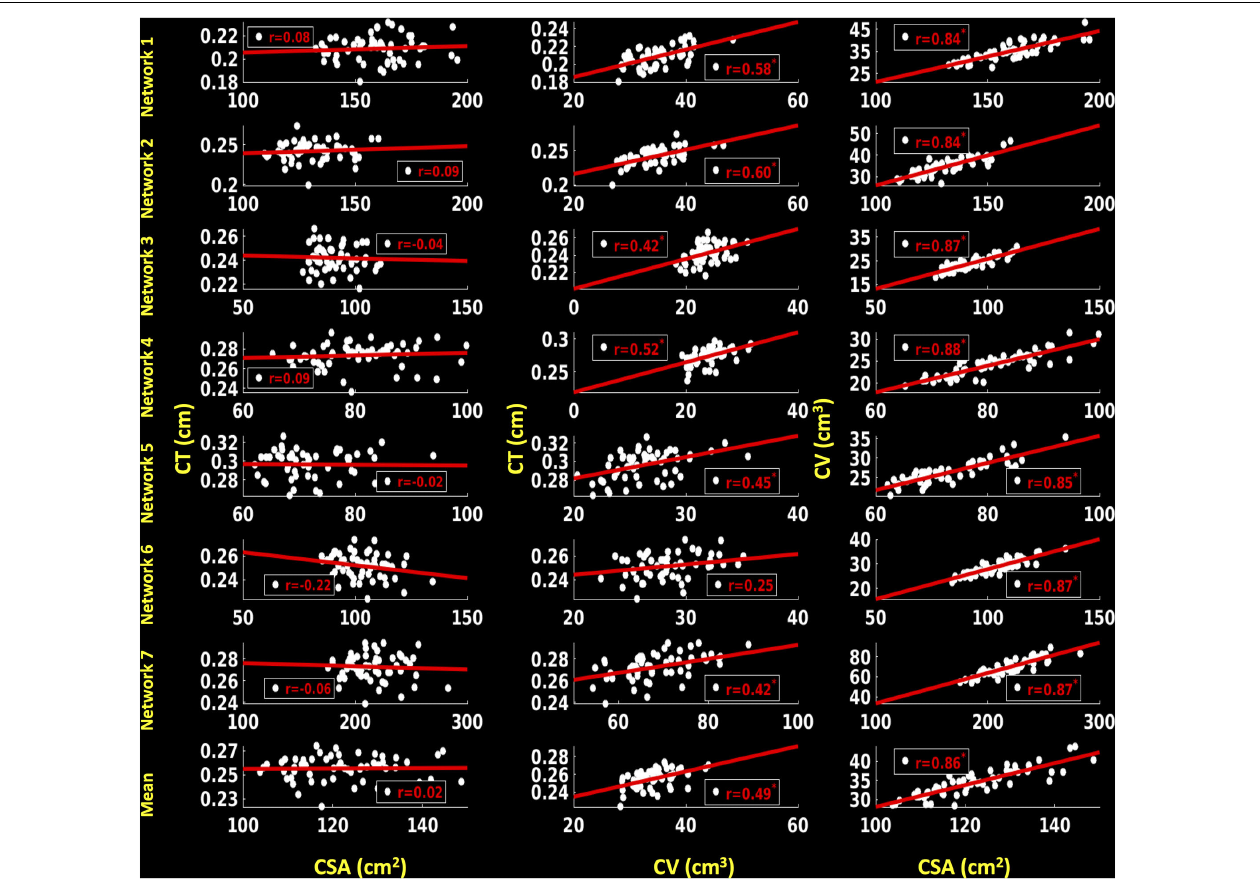
FIGURE 8 | Correlations between cortical surface area (CSA) and cortical thickness (CT), cortical volume (CV) and CT and between CSA and CV for left hemisphere. Linear plots showing non-significant association between CSA (cm 2 ) and CT (cm), significant or trend toward significant positive association between CV (cm 3 ) and CT (cm) ( ∗ p < 0.05, corrected for multiple comparisons), and significant positive association between CSA (cm 2 ) and CV (cm 3 ) ( ∗ p < 0.05, corrected for multiple comparisons) for seven functional networks and mean over seven functional networks on left